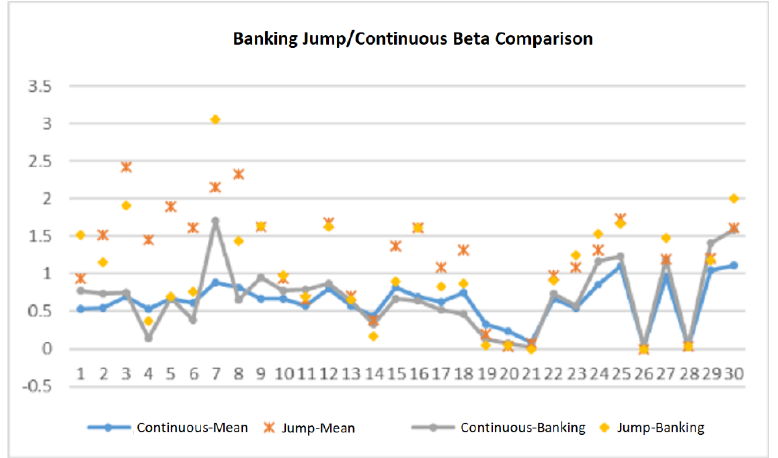
Figure 1: Comparison of banking jump/continuous betas with industries averages